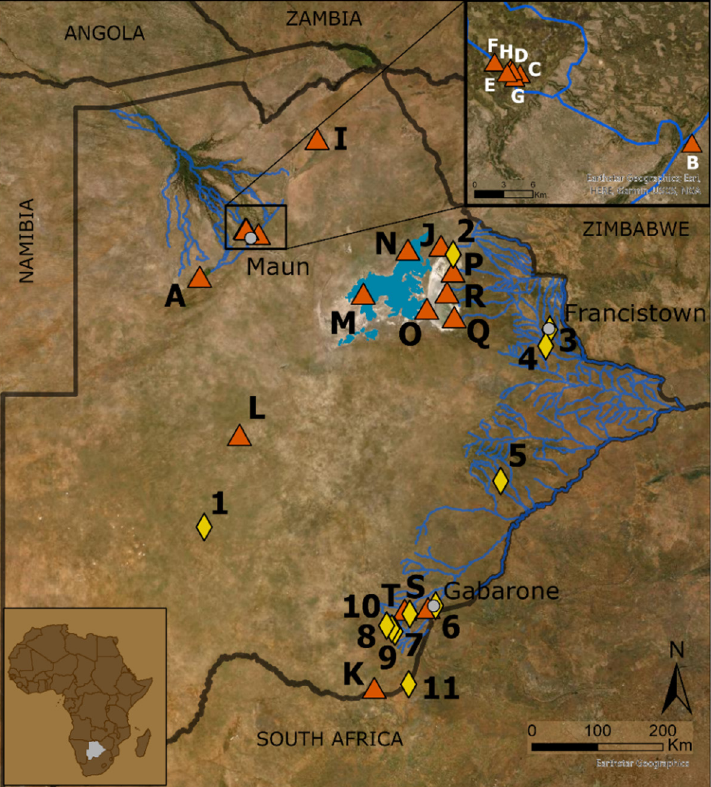
Figure 1. Map of Botswana with the sampling sites. Historical records are indicated with orange triangles and letters (A–T), while our own records are indicated with yellow diamonds and numbers